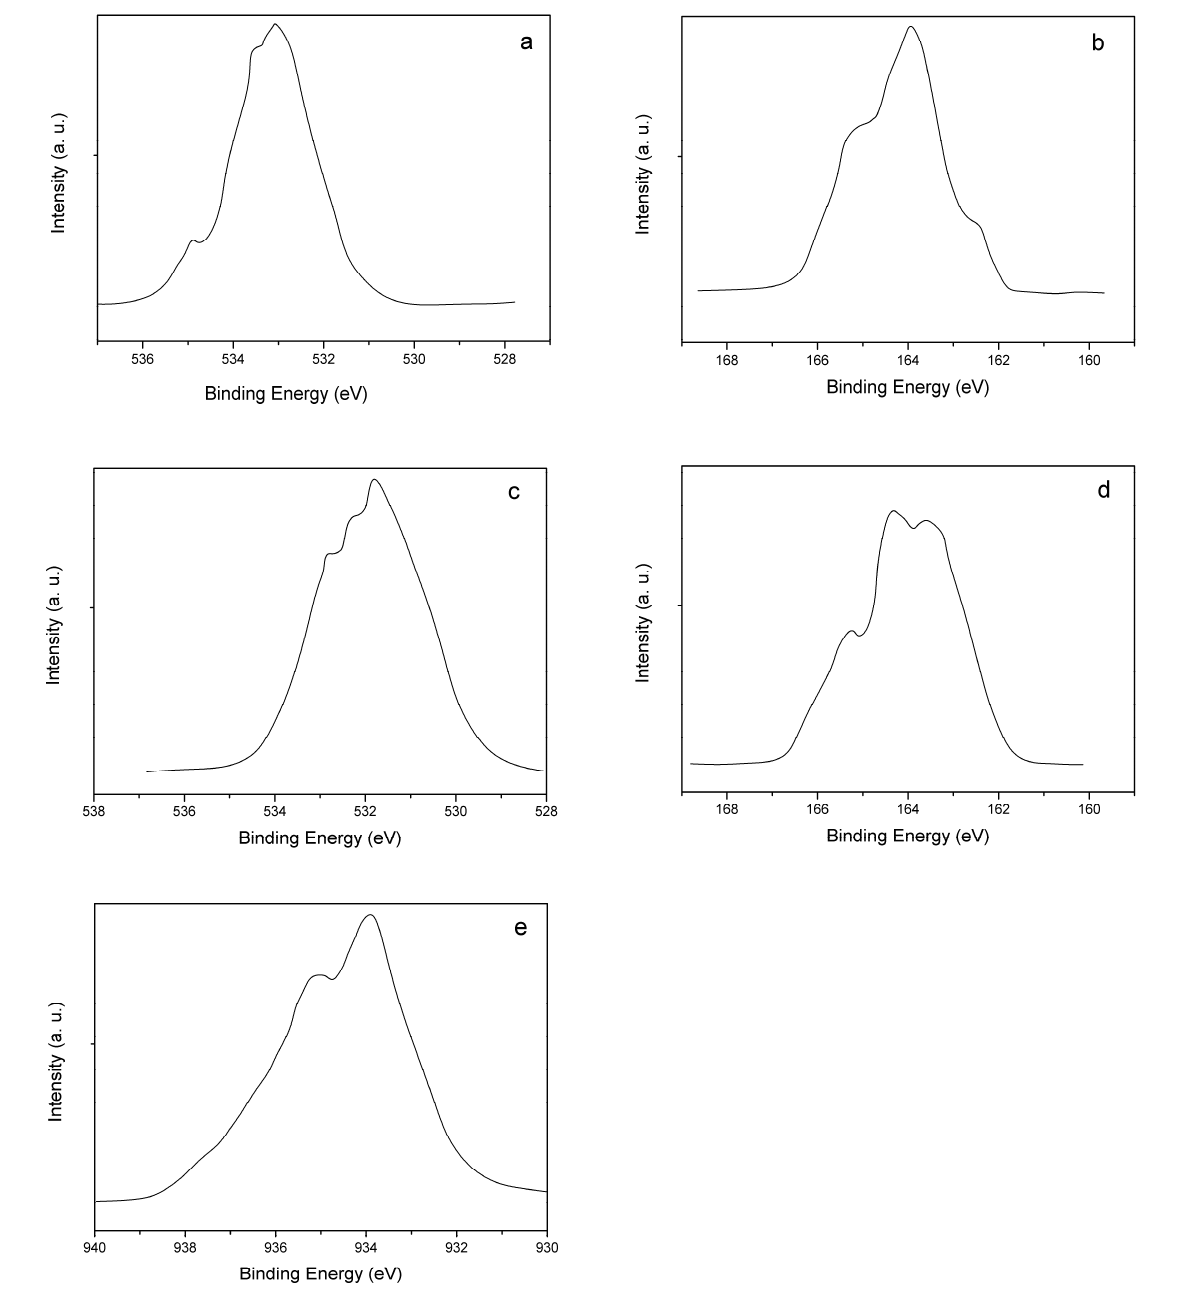
Fig. 3 X-ray photoelectron spectra: (a) O 1s spectrum of free ligand IV ; (b) S 2p spectrum of free ligand IV ; (c) O 1s spectrum of Cu(L IV ) 2 ; (d) S 2p spectrum of Cu(L IV ) 2 ; (e) Cu 2p spectrum of Cu(L IV ) 2